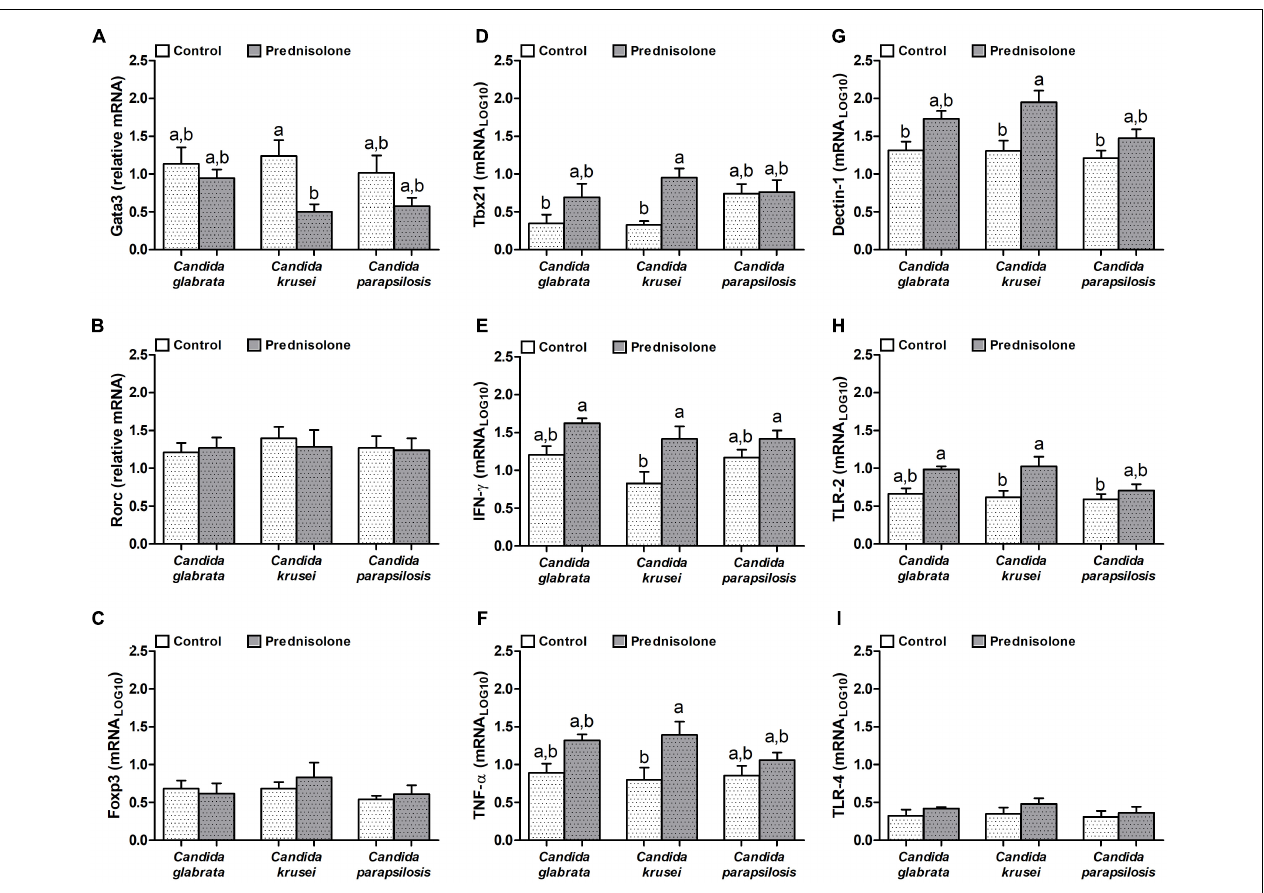
FIGURE 5 | Increased mRNA expression for pro-inflammatory markers in the brain of immunosuppressed C. krusei infected mice. Relative mRNA expression of GATA3 (A) , RORc (B) , Foxp3 (C) , Tbx21 (D) , IFN- γ (E) , TNF- α (F) , Dectin-1 (G) , TLR-2 (H) , and TLR-4 (I) in brain samples of immunocompetent (Control) and immunosuppressed (Prednisolone) infected mice. The results are expressed as mean ± SEM (different letters indicate statistical difference among groups analyzed by One-way ANOVA with post hoc Tukey test; p < 0.05; n =